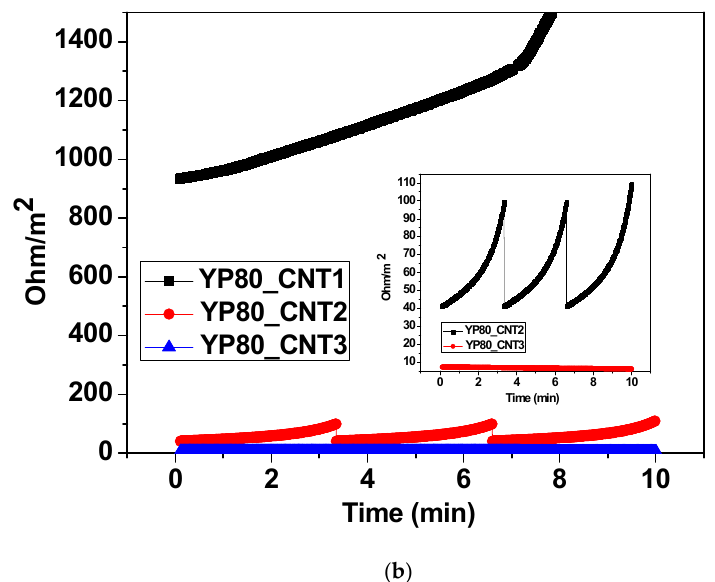
YP80_CNT1. Their large number of porous behaviors increased the high active surface Figure 6. Relationship between impedance and resistance; ( a ) EIS plot and ( b ) t-R plot. area and produced higher electron volume essential for LIBs and LICs. Figure 7 shows changes in charge–discharge caused by time and voltage variations. All three types of samples showed the same type of charge-discharge curves. As samples showed a spherical and hemispherical structure, the distance between the YP80 and CNT molecules was low and strongly bonded. Finally, YP80_CNT3 showed a specific capacity effect that was about three times higher than YP80_CNT2 and about five times higher than